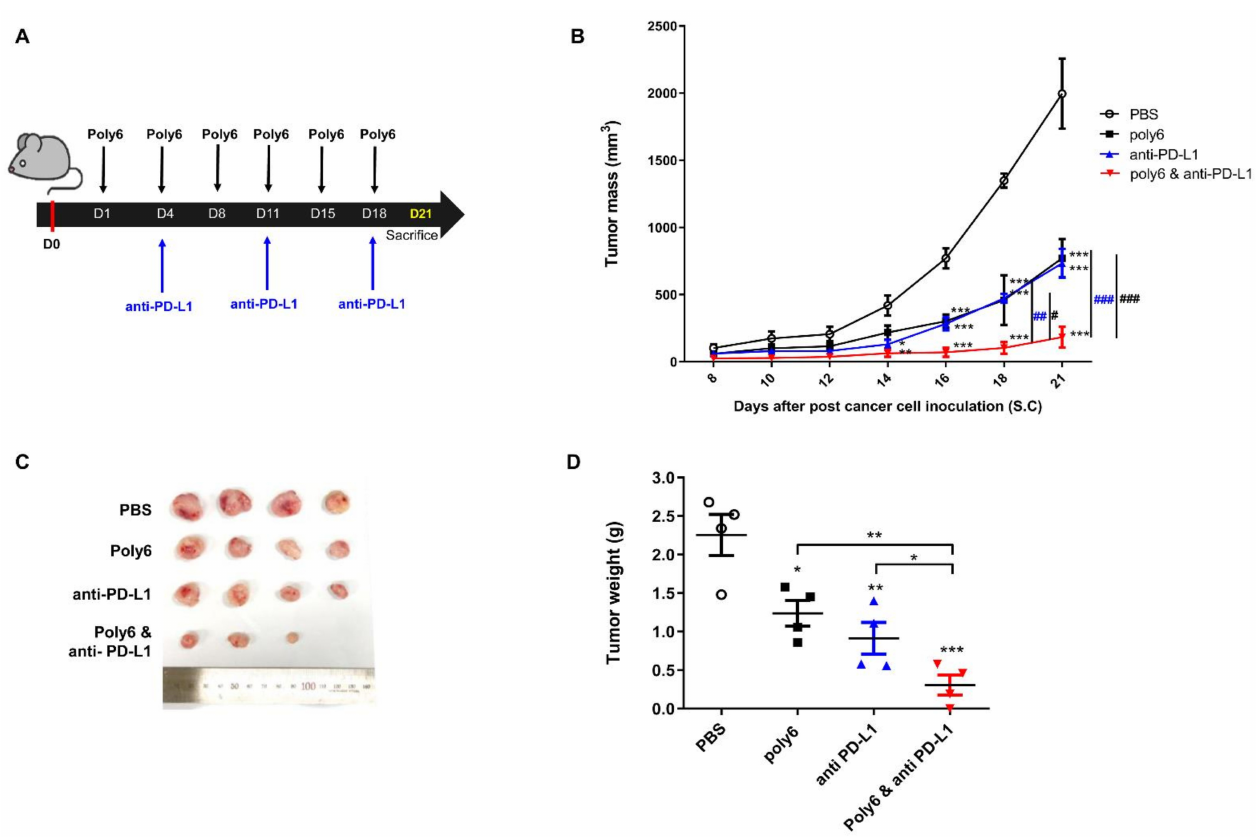
Figure 6. Combination of Poly6 with anti-PD-L1 Ab treatment exerts enhanced anticancer effects in a cancer bearing mouse model. ( A ) Schematic combination therapy in vivo experiment schedule. Poly6 peptide (10 µ g) was subcutaneously injected, and anti-PD-L1 antibody (100 µ g) was intraperitoneally injected following the injection schedule. MC38 cancer cells (1 × 10 6 cells/100 µ L) were inoculated on day 0 in C57BL/6 mice ( n = 4). ( B ) Tumor growth was observed for 21 days. ( C ) Tumor tissue image on day 21. ( D ) Weight of tumor tissue was compared. These results are representative of two independent experiments. Significance differences (* p < 0.05, ** p < 0.01 and *** p < 0.001) among different groups are shown in related figures, and the other significance differences (# p < 0.05; ## p < 0.01 and ### p < 0.001) are used to compare with the Poly6 and anti-PD-L1 combination group. The data are presented as the mean ± standard error of mean (SEM). of the mice ( n = 4). Student’s t -test, one- and two-way ANOVA were